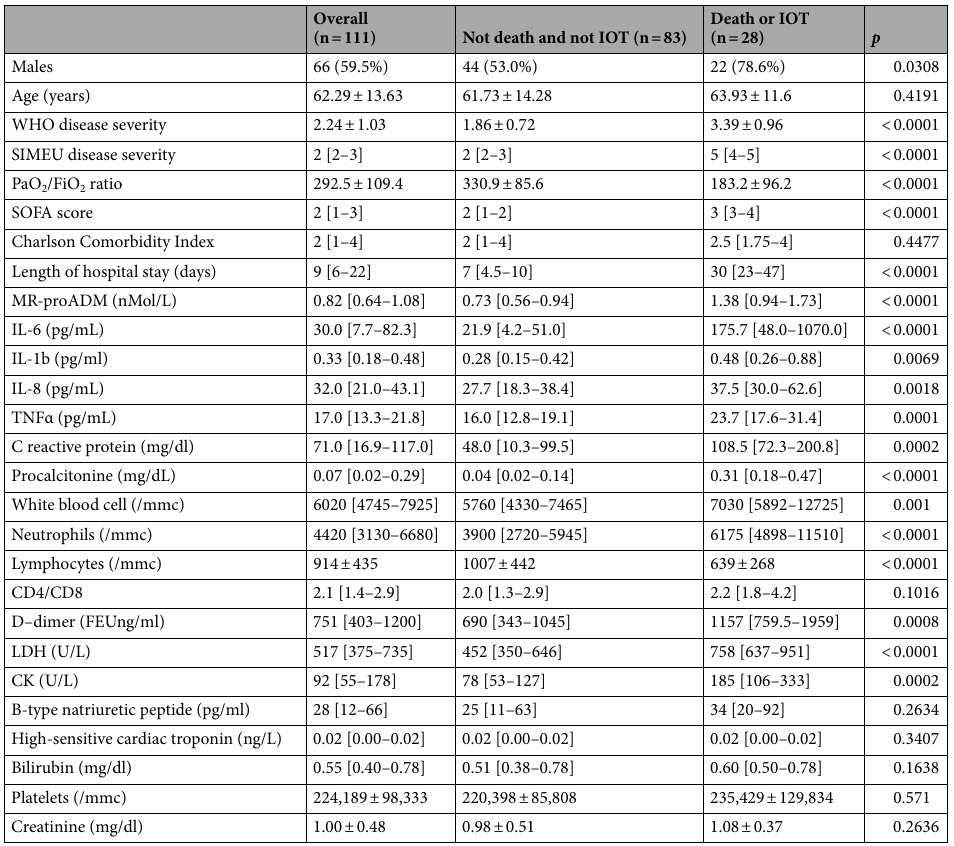
Table 1. Overall study population and comparison between the group with combined event of Death or IOT and the group without combined